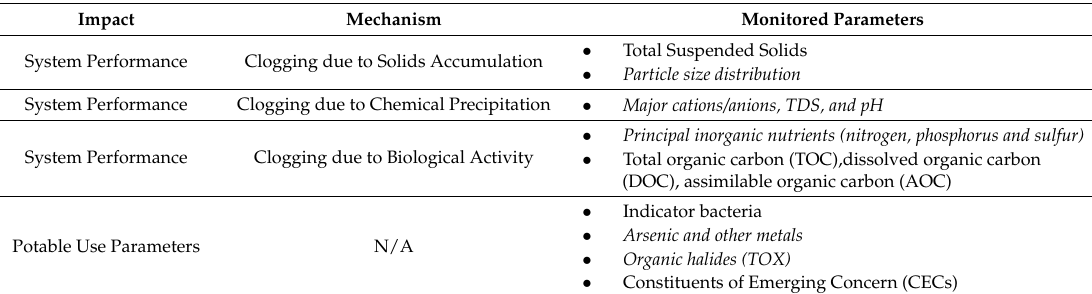
Table 2. Water Quality Parameters of Interest